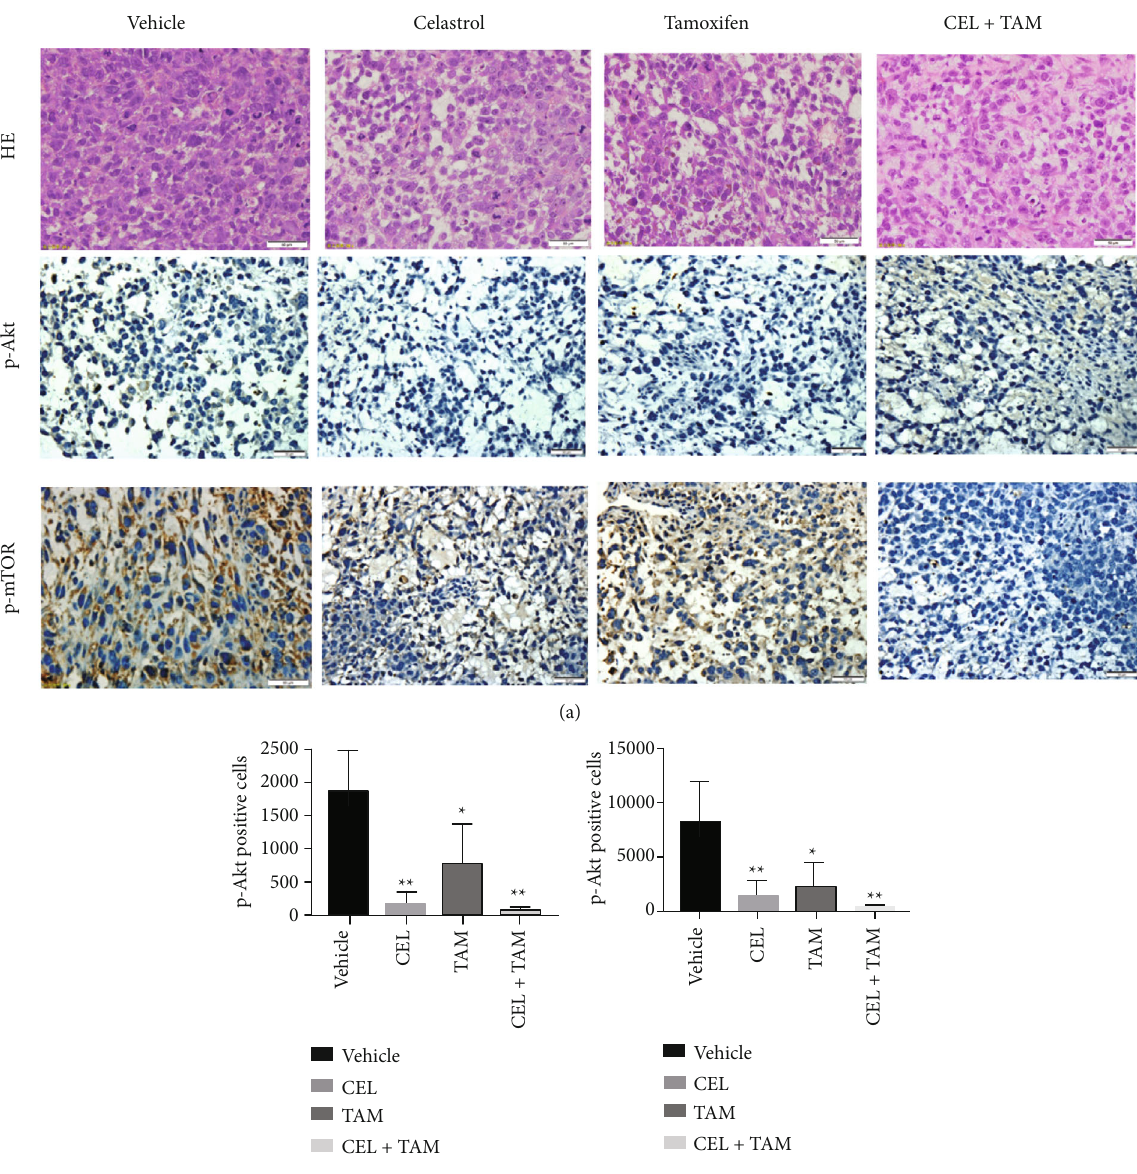
Figure 8: HE staining and p-Akt and p-mTOR detection by immunohistochemical analysis of tumour tissues. The phosphorylation of Akt and mTOR was signi fi cantly repressed in the combination